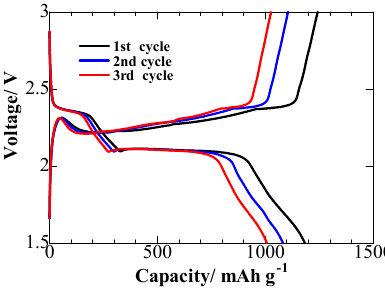
Figure 5. Charge and discharge curves of S/Mn 3 O 4 cathode.